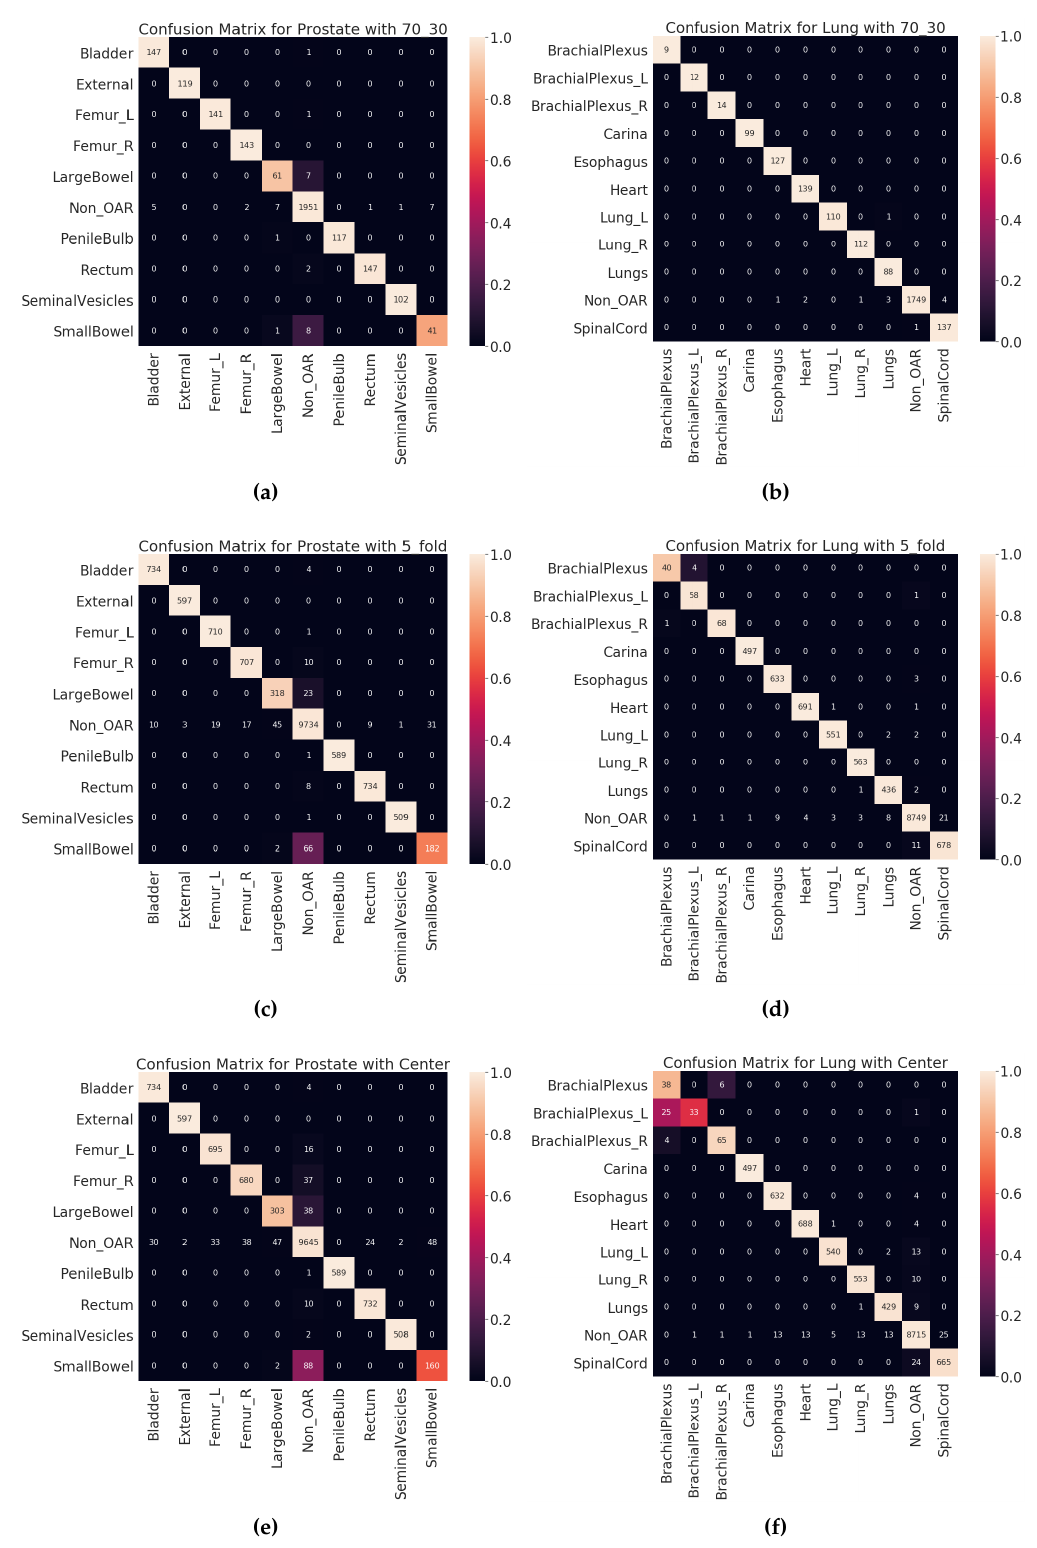
Figure 6. Validation set (VA-ROQS) confusion matrices of different validation types for both prostate and lung. ( a ) Prostate 70:30 split validation. ( b ) Lung 70:30 split validation. ( c ) Prostate 5-fold cross-validation. ( d ) Lung 5-fold cross-validation. ( e ) Prostate VA Center cross-validation. ( f ) Lung VA center cross-validation. Lighter color indicates better prediction. Diagonal indicates the correctly predicted